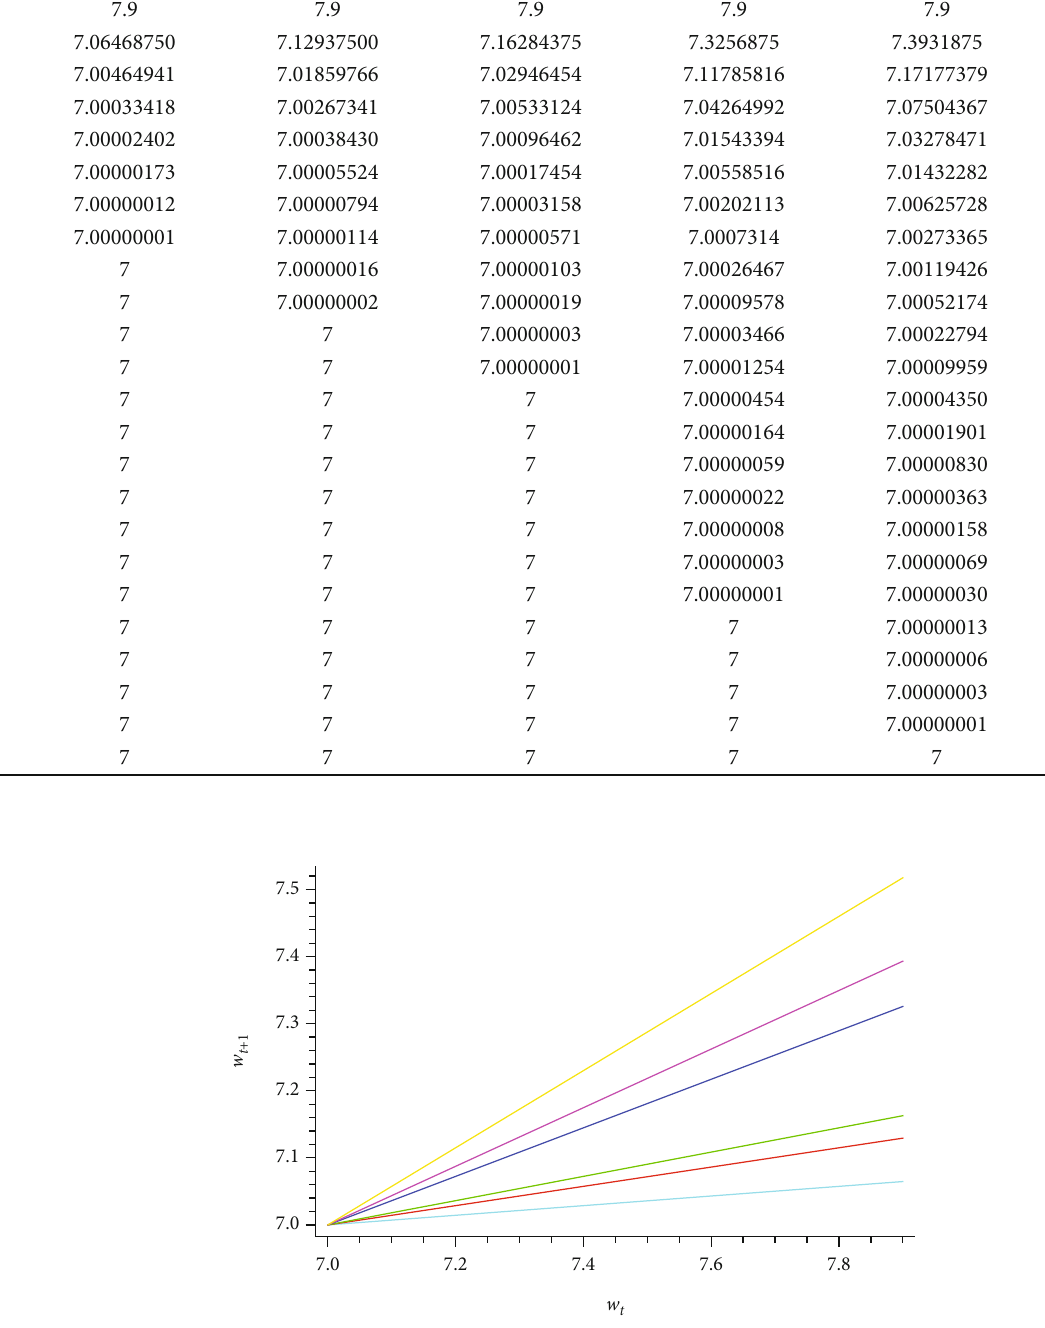
Figure 1: Convergence analysis view of F (cyan), M (red), Picard-S (green), S (blue), Ishikawa (magenta), and Mann (yellow) iteration process for the mapping given in Example